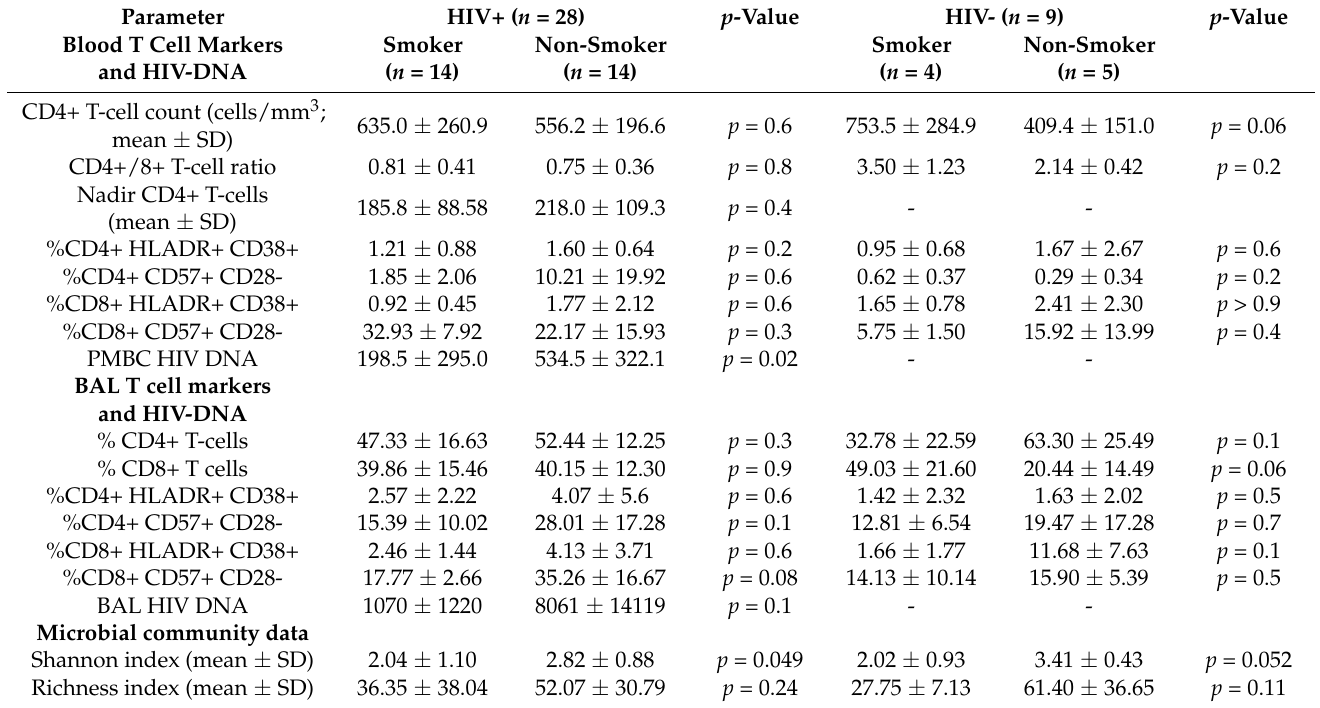
Table 1. Cellular immune activation markers and sequencing